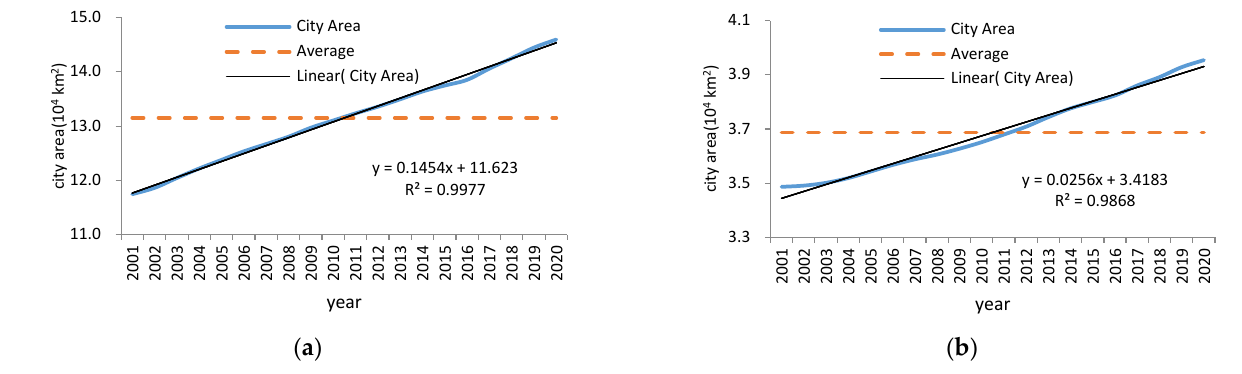
Figure 8. Urbanization area trends from 2001 to 2020 in China ( a ) and the key climatic area ( b ).